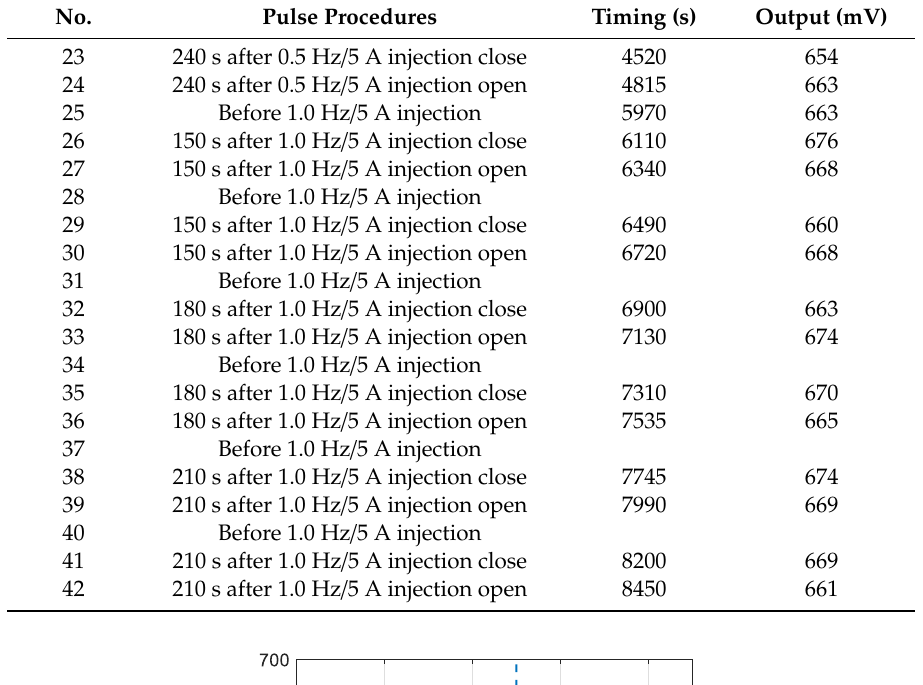
Table 1. Measurement timings and results.